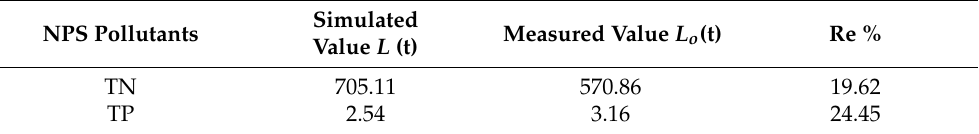
Table 4. Validation results of the five-factor